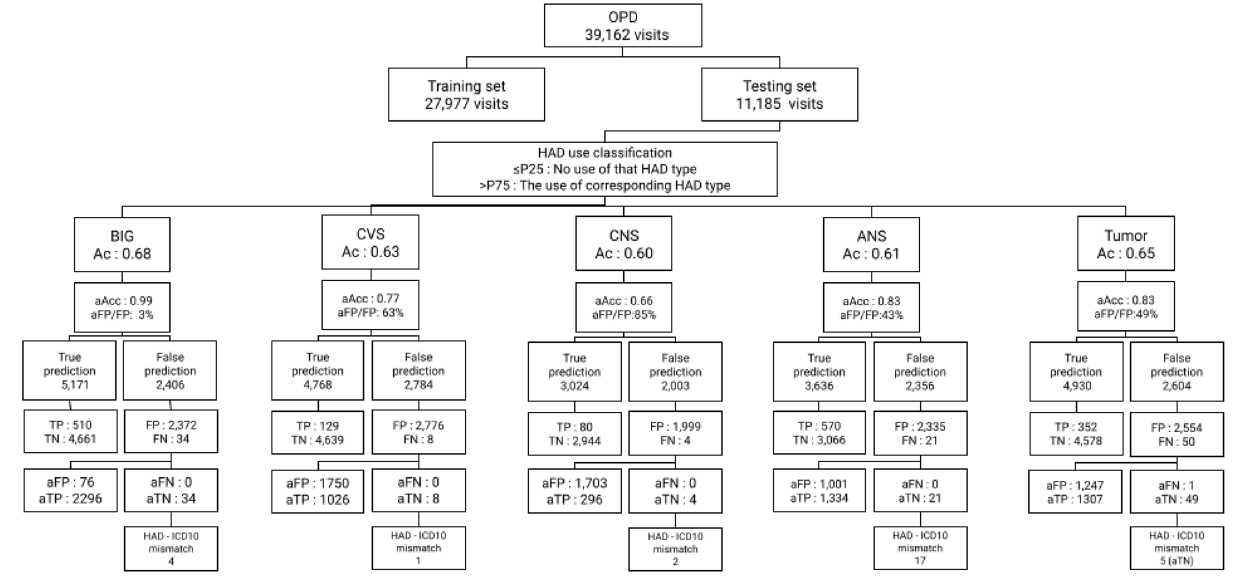
Figure 13. HAD–ICD10 mismatch in outpatient data set in Cycle 1.